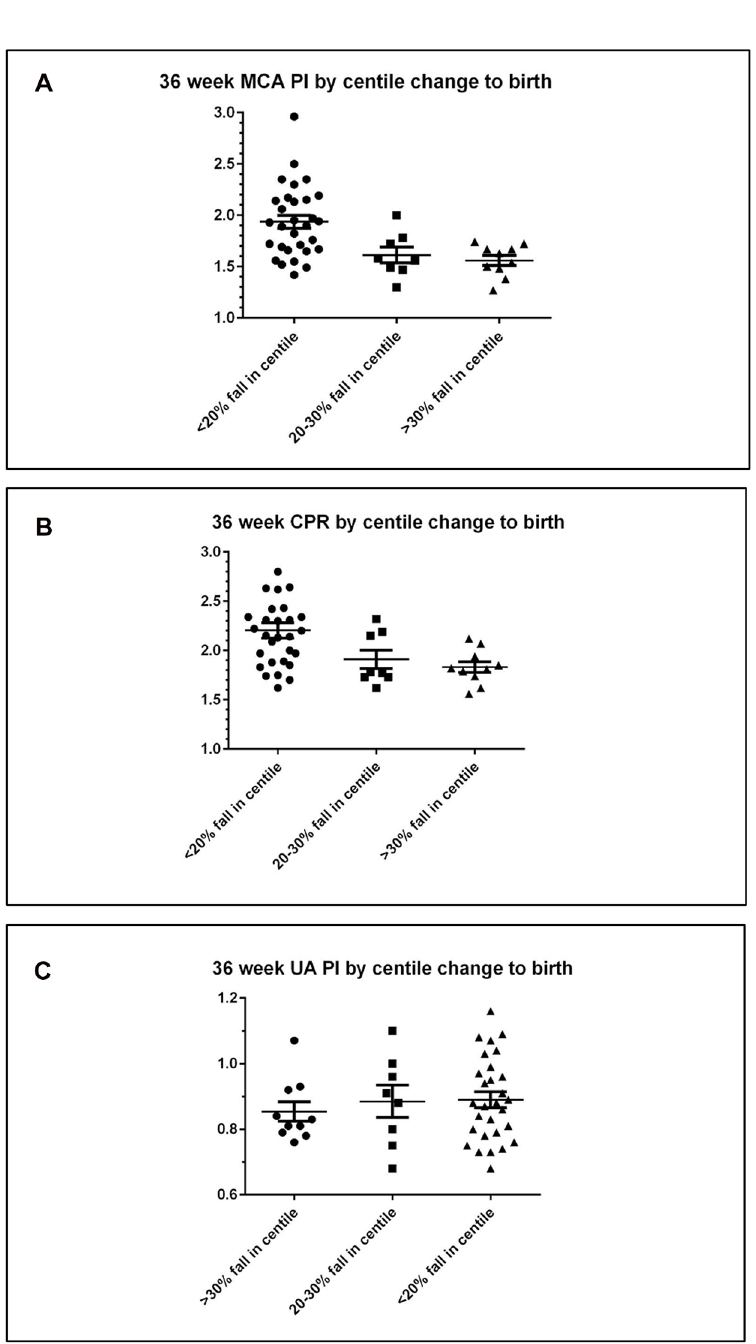
Fig 3. Doppler assessments performed at 36 weeks according to change in fetal growth centile by categories; (i) < 20% fall in customised centile between 28 week ultrasound and birth (n = 30), (ii) 20 – 30% fall in customised centile between 28 week ultrasound and birth (n = 9), (iii) > 30% fall in customised centile between 28 week ultrasound and birth (n = 9) for MCA-PI (Fig 3a), CPR (Fig 3b) and UA-PI (Fig 3c).